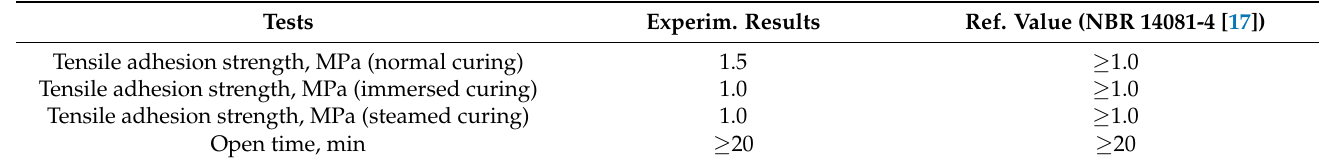
Table 1. Mechanical characterization tests of the adhesive mortar.